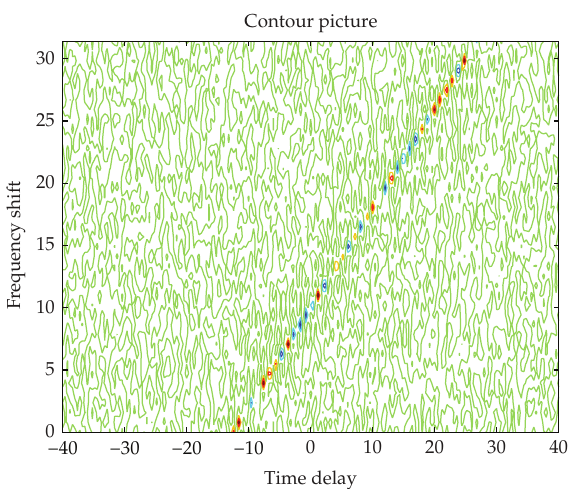
Figure 8: The contour picture of WDL of f (cid:4) t (cid:5) with SNR (cid:7) −